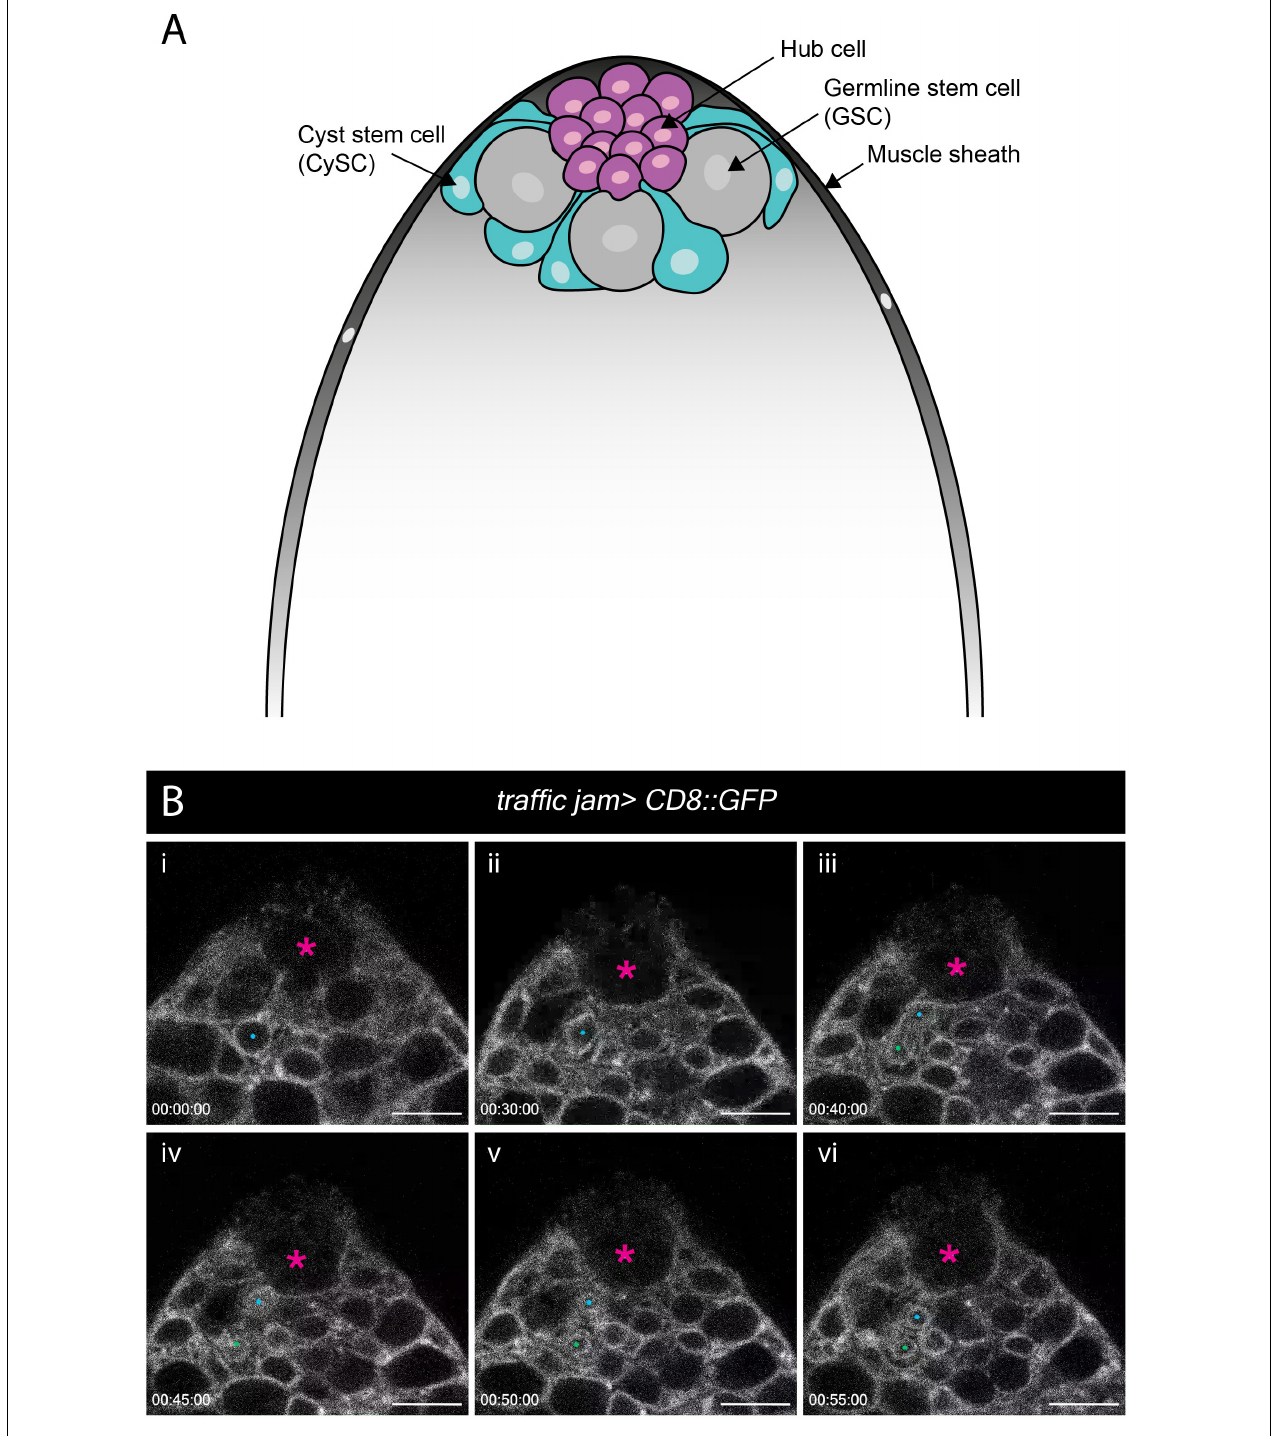
FIGURE 5 | Spatial organization of stem and niche cells in the adult testis and mitosis in the CySCs. (A) Schematic of the adult testis, which is encased in a muscle sheath (dark gray). Anchored at the apical tip of the tissue is a cluster of small post-mitotic cells known as the hub (magenta), which constitutes the stem cell niche. Two stem cell populations are in direct contact with the hub – germline stem cells (GSCs, gray) and cyst stem cells (CySCs, cyan). GSCs are large, round cells that closely associate with the hub. CySCs are located behind GSCs and extend thin membrane protrusions between GSCs to contact the hub. (B) A time-series extracted from Movie 9 of a cultured traffic jam > CD8::GFP adult testis. The hub is marked with a magenta asterisk. A CySC that undergoes a division is marked with a blue dot (i, ii). The nuclear membrane is visible during the division and takes on a characteristic diamond shape (ii) before the two daughter cells (blue and green dots; iii, vi) pull apart. Timescale displayed as hr:mm:ss, scale bar = 10 µ m.